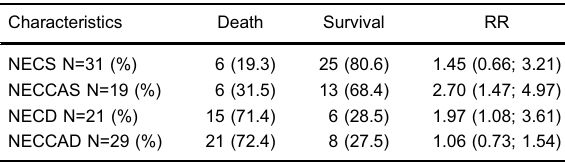
Table 2. Number (%) of deaths in the groups and relative risk (RR) according to the presence of heart disease and type of surgical treatment.